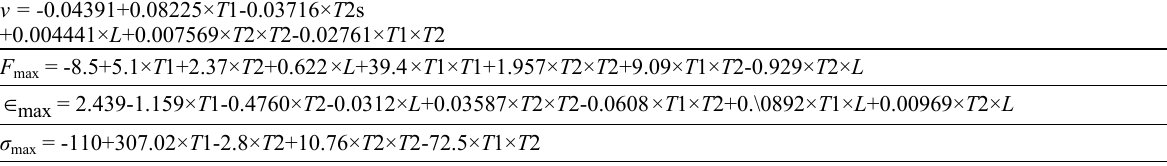
Table 2. Simplified stepwise regression models